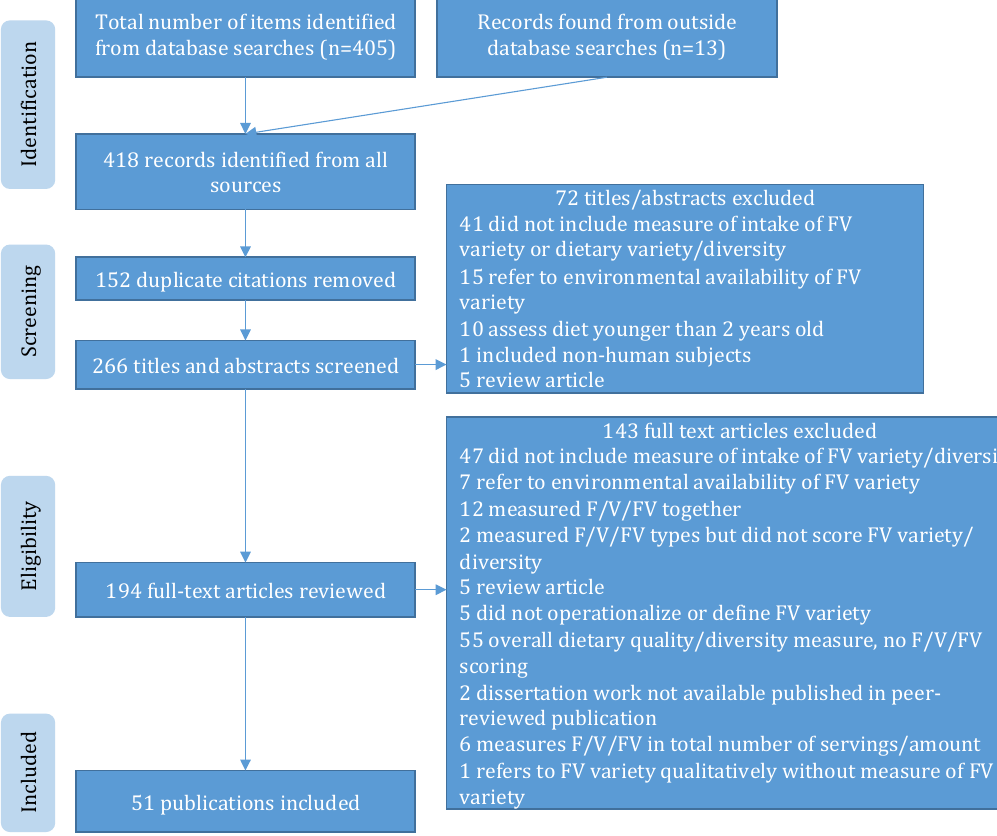
Figure 2. Flow diagram of methods: identification, screening, eligibility, and inclusion of records with reasons for exclusion at each stage [28,29].